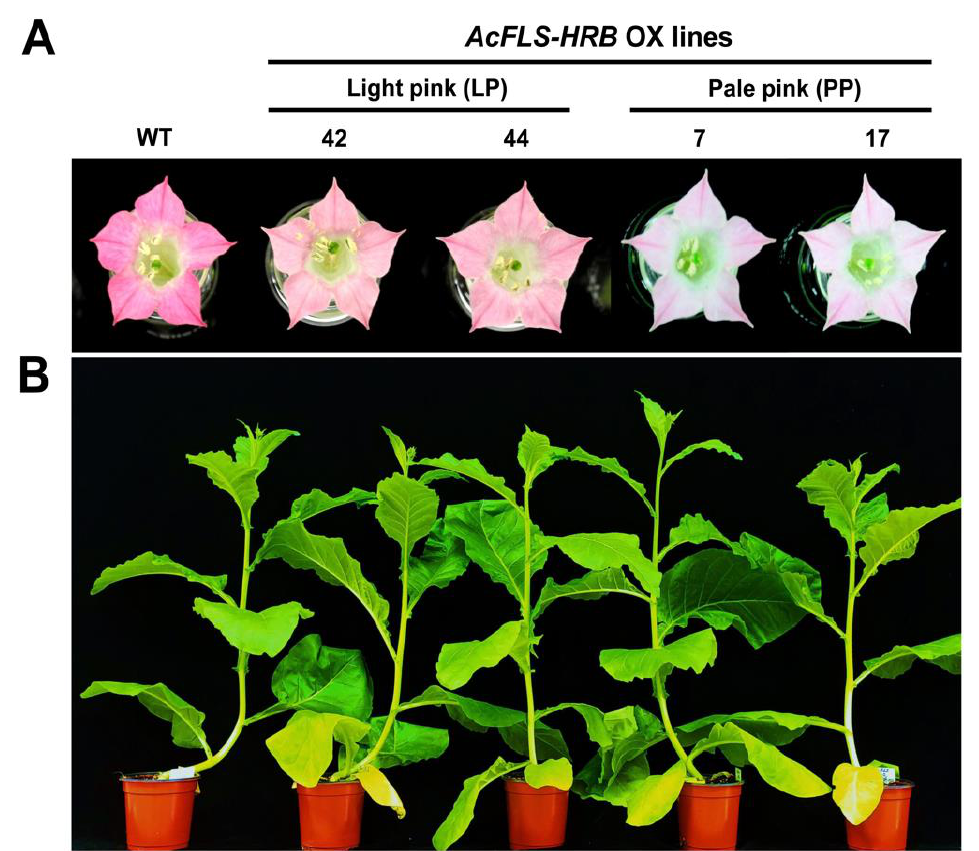
Figure 3. Phenotypes of transgenic tobacco expressing AcFLS - HRB . Phenotypes of flowers ( A ) and 9-week-old plants ( B ) expressing AcFLS - HRB. WT, wild-type; 42, 44, 7, and 17, transgenic lines with light pink/pale pink flowers.